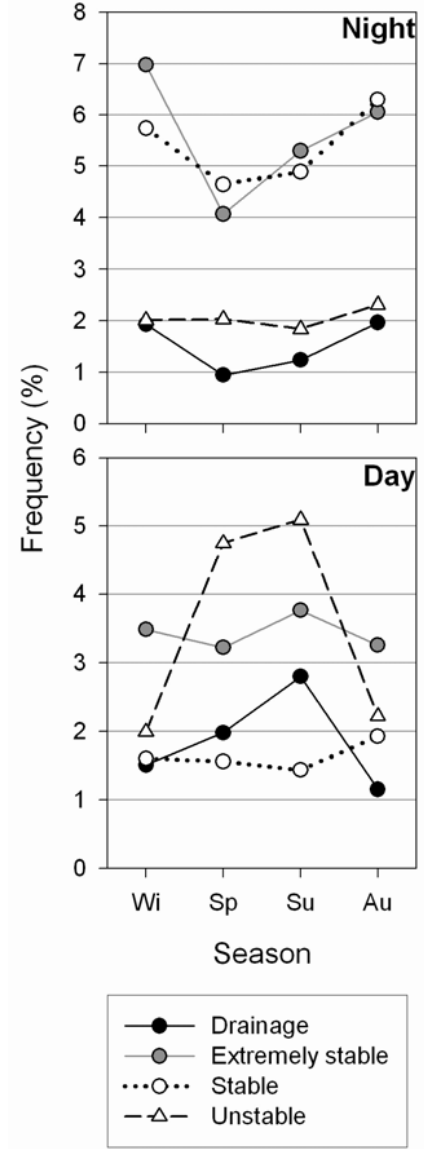
Figure 4.- Seasonal distribution of profiles used. Fig. 4. Seasonal distribution of profiles